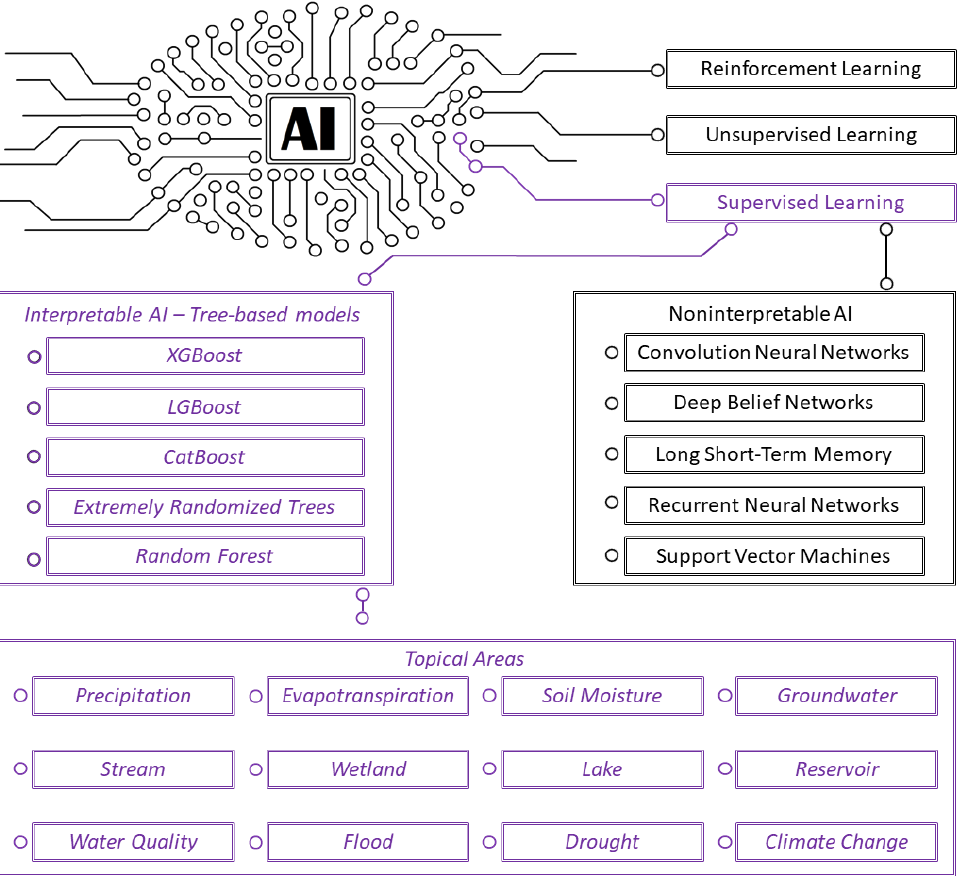
Figure 1. Taxonomy of AI and topical areas selected for this study. This study focuses on subject matters that are embedded within the purple